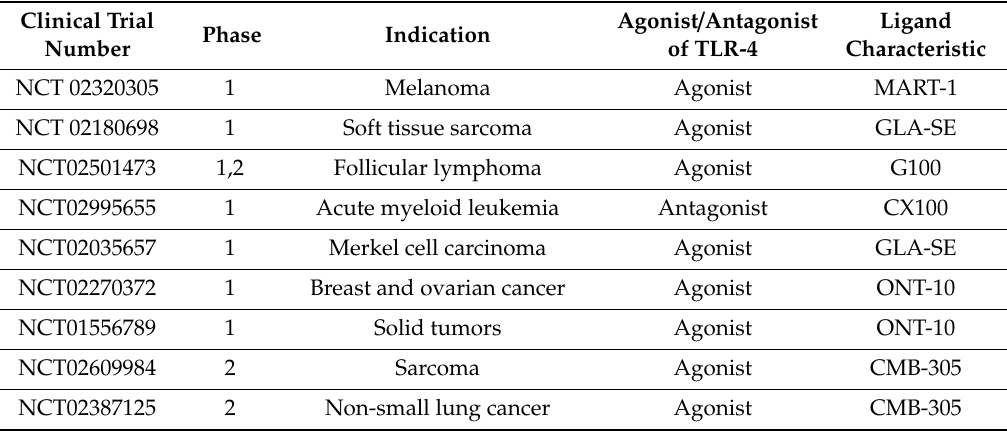
Table 3. First- and second-phase clinical trials concerning TLR-4 agonists and antagonists in the treatment of various